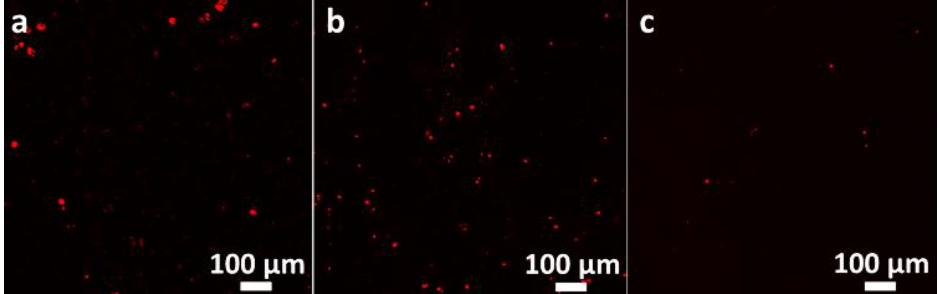
Figure 9. Fluorescent detection of plasmid mCherry-transfected HeLa cells by confocal microscopy induced by: ( a ) commercial K2 ® kit compared with ( b ) cellular magnetofection and ( c ) passive trans- fection using MSNs@SPIONs@PDA.